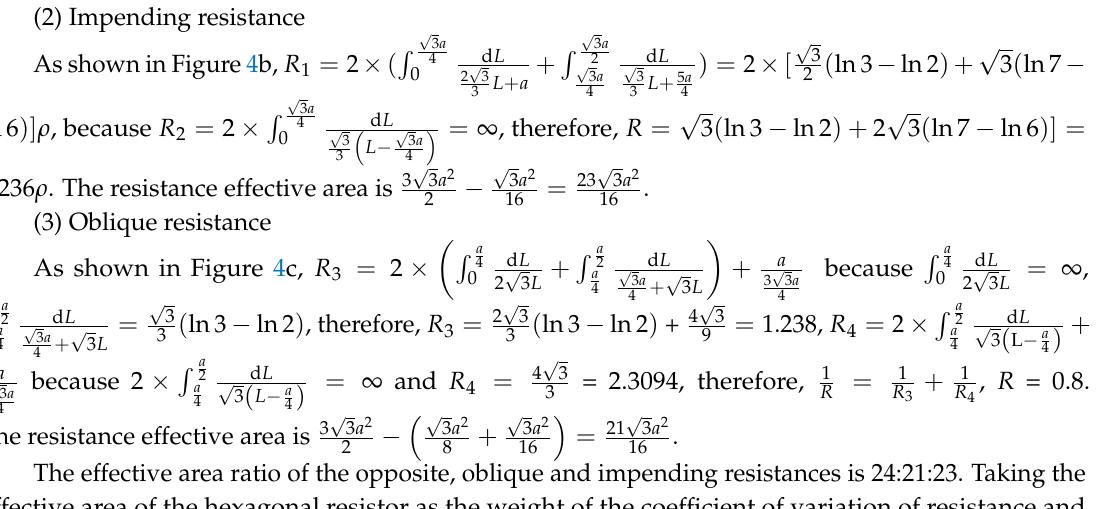
Figure 4. Schematic diagram of the resistance calculation. ( a ) Calculation diagram of counter resistance; ( b ) Calculation diagram of impending resistance; ( c ) Calculation diagram of oblique resistance.